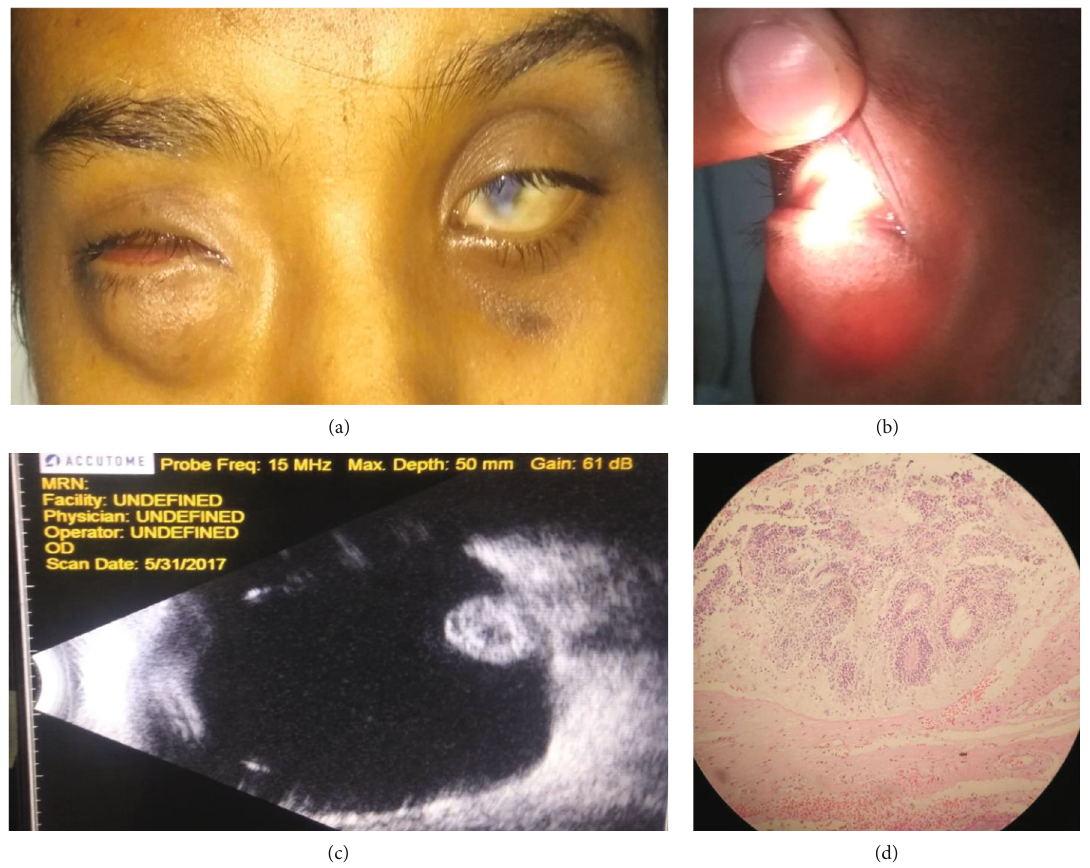
Figure 1: (a) RE congenital cystic eyeball in a 14-year female: LE microcornea with inferior scar. (b) Cyst shows a positive transillumination test. (c) B-scan USG of the RE showing a stump of optic nerve-like structure in the posterior aspect of a large cyst. (d) Histopathology of the excised cyst showing cyst lined by neuroglial tissue. No speci fi c remnants of the eye could be identi fi